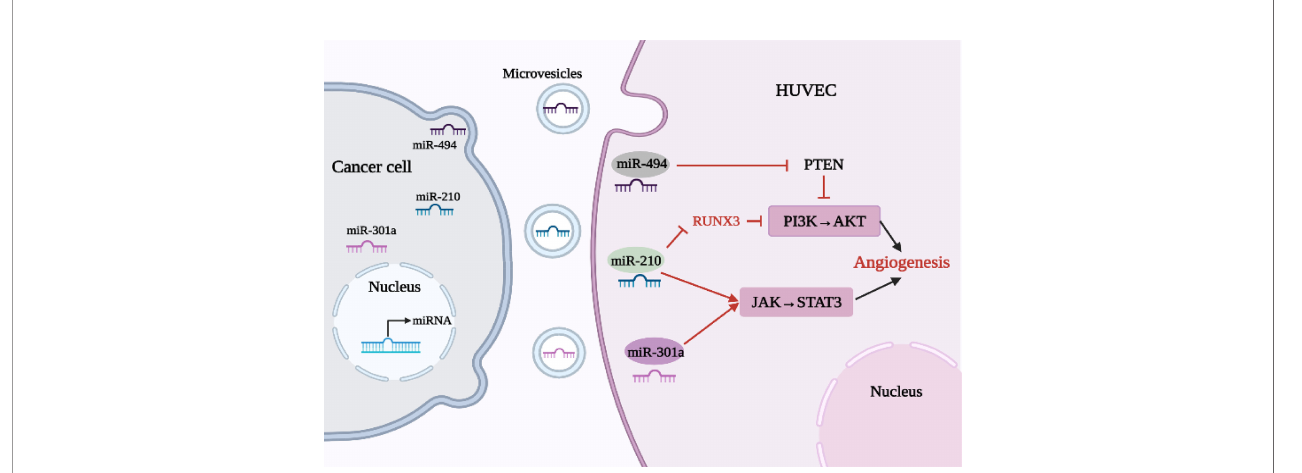
FIGURE 3 | Relationship between oncogenic miRNAs and angiogenesis in lung cancer.